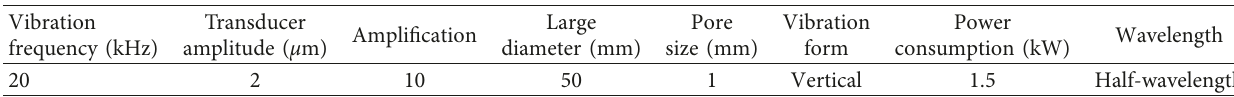
Figure 3: The apparatus of ultrasonic vibration-assisted abrasive waterjet. (a) The pneumohydraulic intensifier. (b) The device of ultrasonic vibration-assisted waterjet. Table 2: The main parameters of ultrasonic